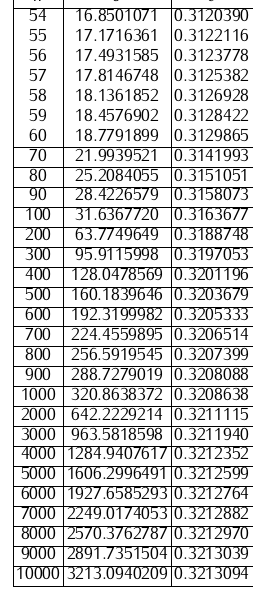
( n,δ ) > 0 where δ = cn . n